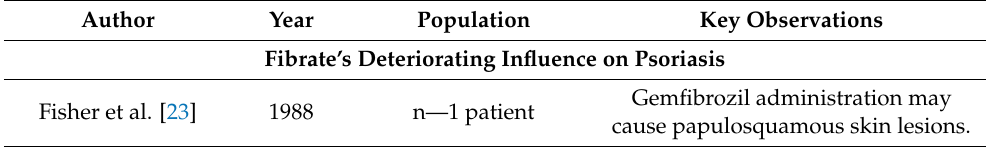
Table 7. Summary of the studies on fibrate’s deteriorating influence on